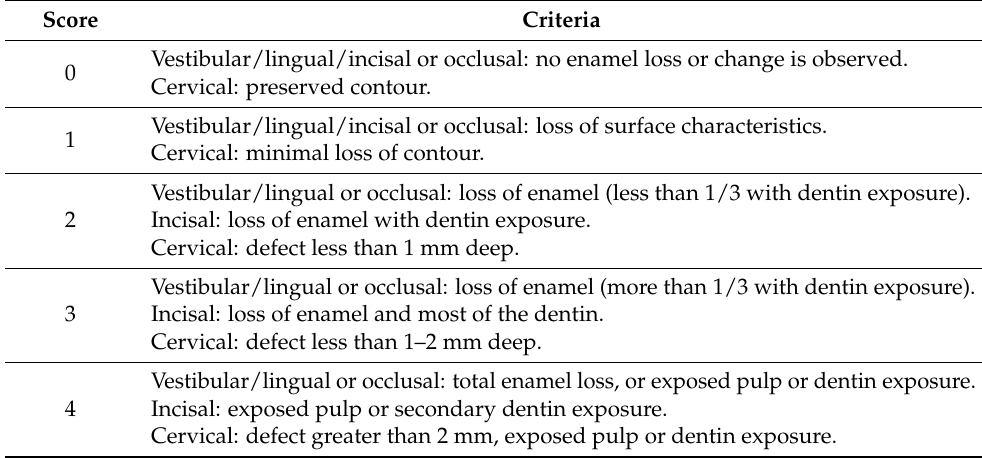
Table 2. Smith and Knight visual index.